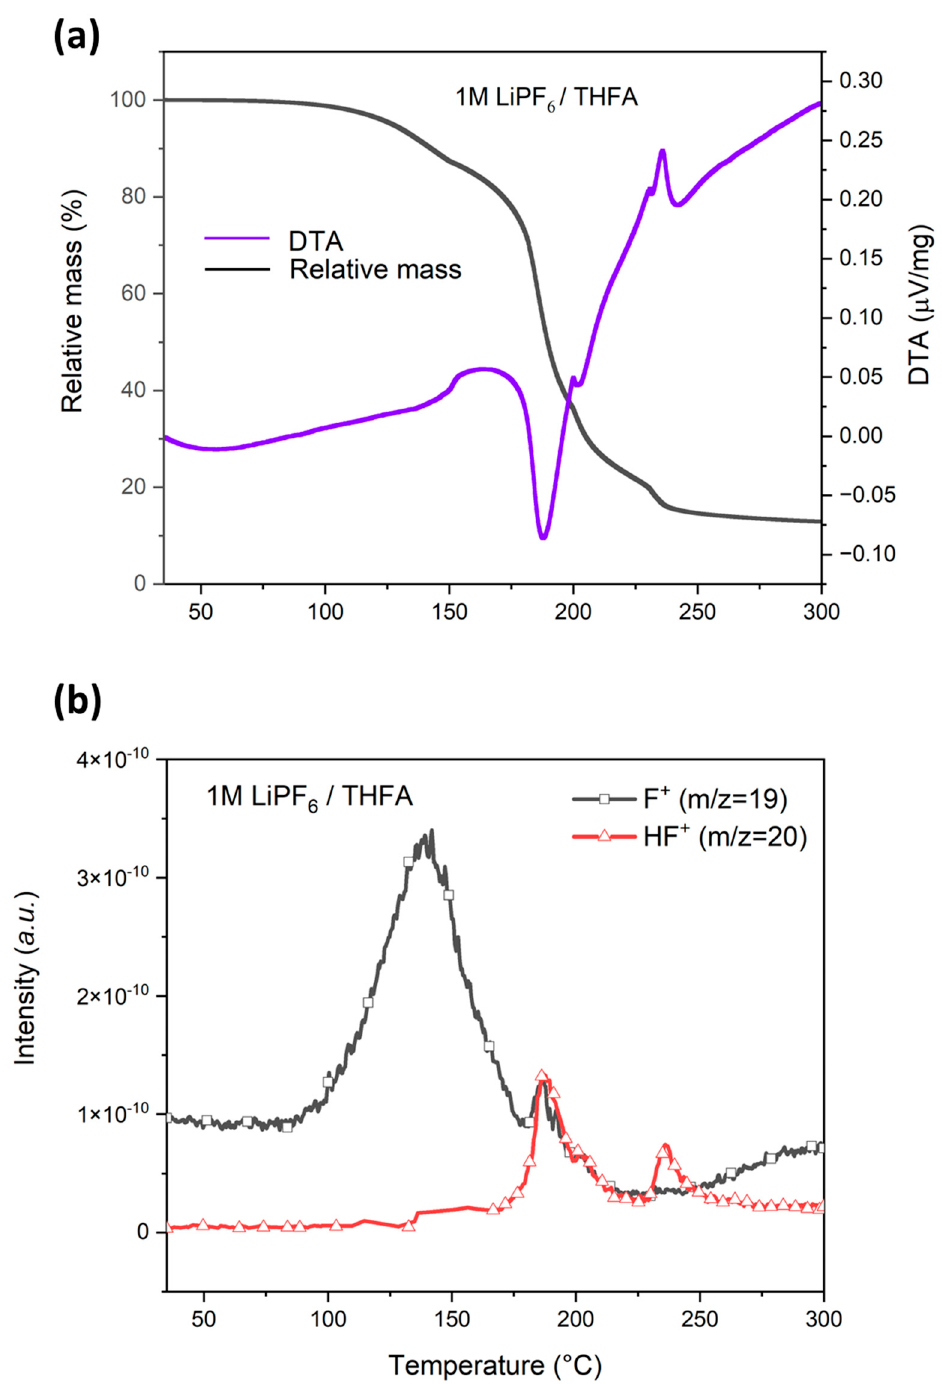
Figure 5. ( a ) TG/DTA curves of HF generation temperature in 1 M LiPF 6 /THFA electrolyte solution without water, and ( b ) the simultaneous F + and HF + identification using MS.